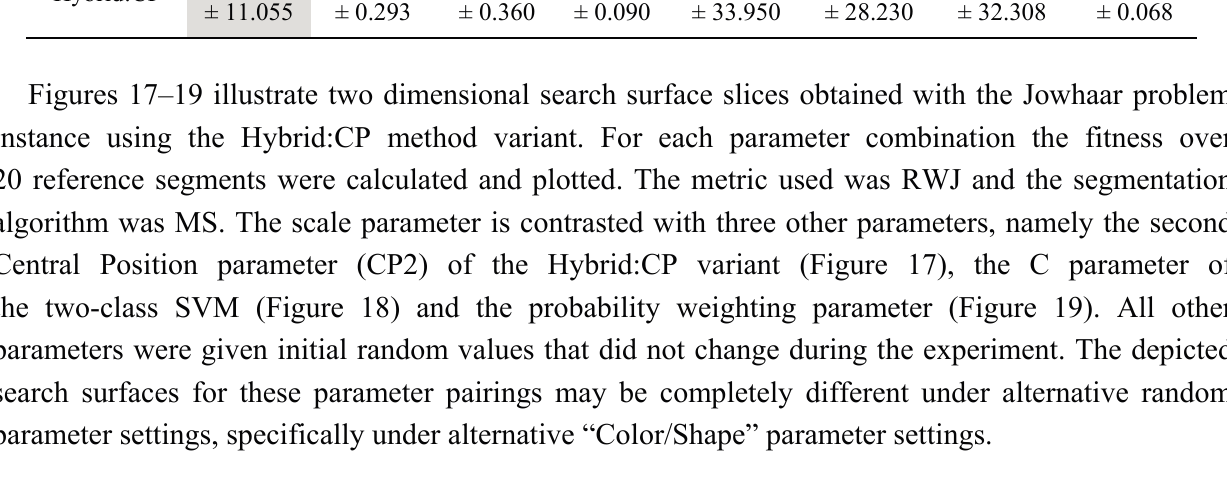
Figure 17. Search landscape slice with the Scale and CP2 parameter of the Hybrid:CP method